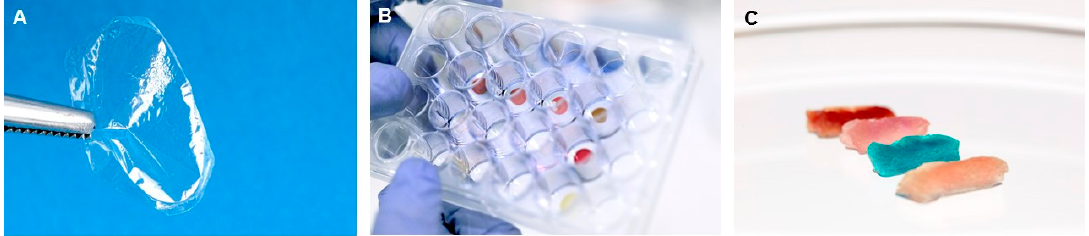
Figure 1: Photographs of solid-state silk materials. ( A ) Unmodified of recombinant honeybee silk fabricated into a film; ( B ) Honeybee silk films with various macrocycles cast in a 24-well plate; ( C ) Honeybee silk sponges with incorporation of heme b (red), cobalt corrin (pink), zinc phthalocyanine (blue) and palladium porphyrin (orange).